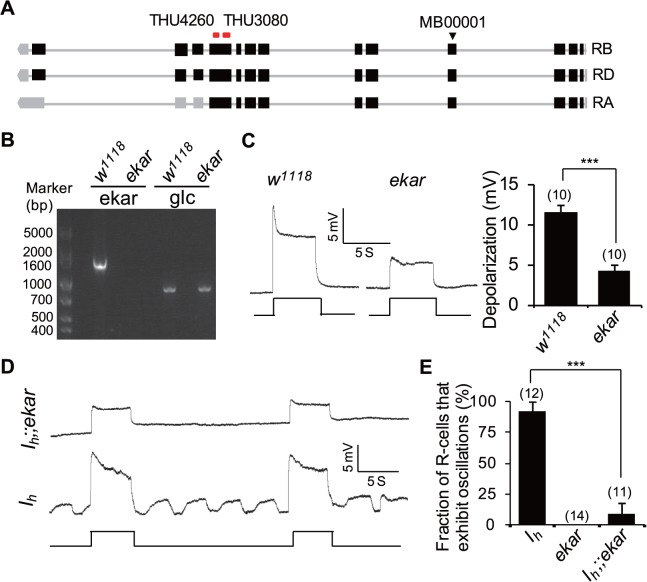
The kainate receptor EKAR receives the retrograde glutamate signal in photoreceptor terminals.(A) Annotated transcriptions of the ekar gene. The transposon insertion site of Mi{ET1}CG9935
MB00001 is indicated with a triangle. Recognized sites of two RNAi lines are labeled at the top. (B) RT-PCR analysis reveals an absence of ekar mRNA in Mi{ET1}CG9935
MB00001 line. The Glc gene is used as a positive control. (C) Intracellular recordings of light responses in wild-type and ekar mutant photoreceptors. Quantification of light-induced depolarization is presented in the right panel. For each genotype, ten photoreceptors from ten flies were measured, and the data are presented as mean ± SEM. (D) Intracellular recordings of I
h;;ekar photoreceptors show that ekar mutation suppresses rhythmic depolarization in I
h mutant flies. (E) The fractions of photoreceptors exhibiting the oscillation phenotype are presented. The numbers of recorded photoreceptors are listed.